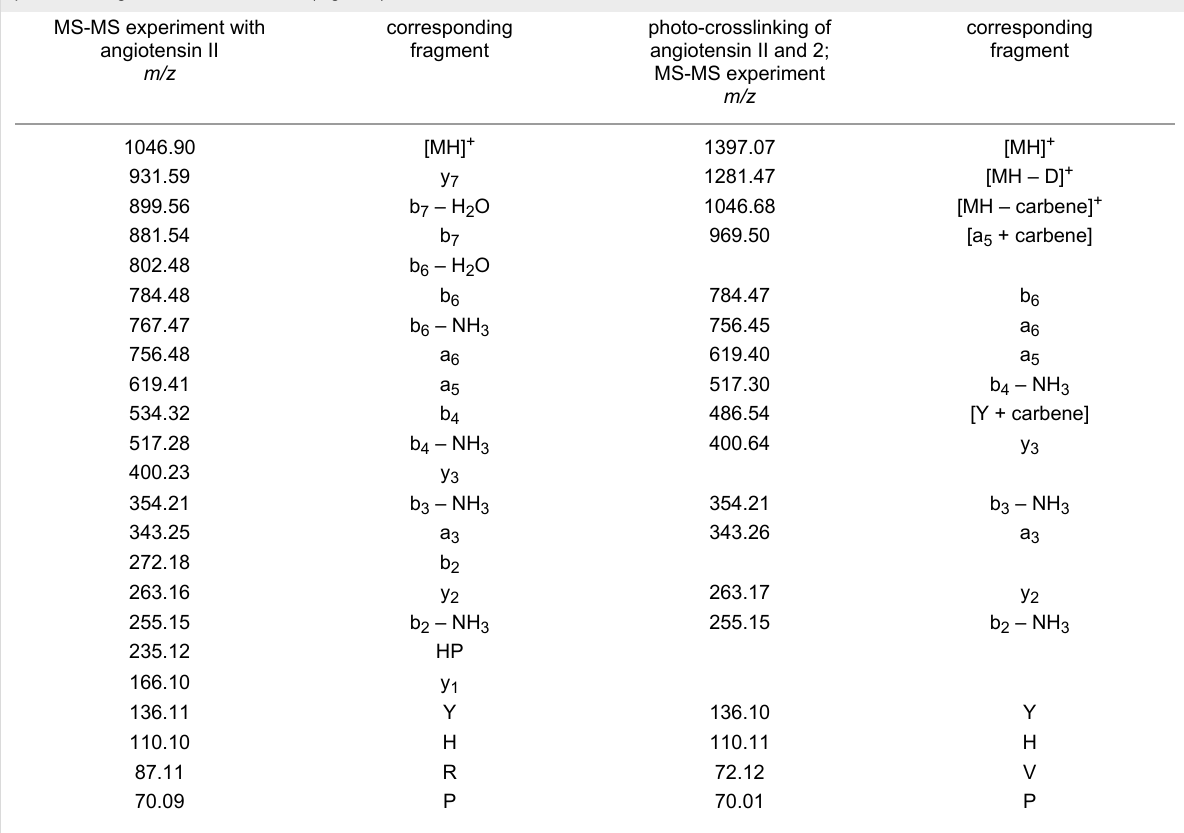
Table 3: Assignment of peptide fragment ion pattern according to Biemann [25]; left two columns: angiotensin; right two columns photo-crosslinked product of angiotensin and diazirine 2 (Figure 4). MS-MS experiment with angiotensin